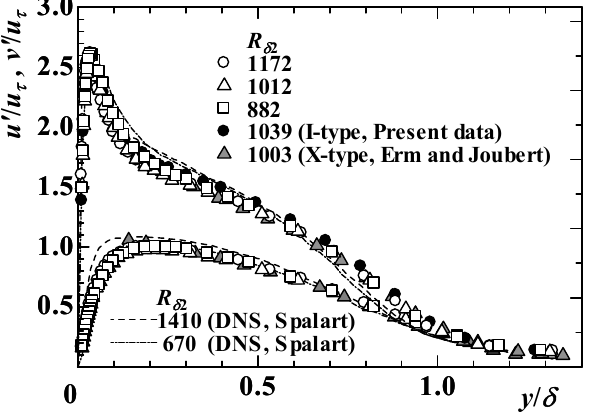
Fig. 16 Distributions of fluctuating velocities u ΄ / u τ and v ΄ / u τ versus y / δ